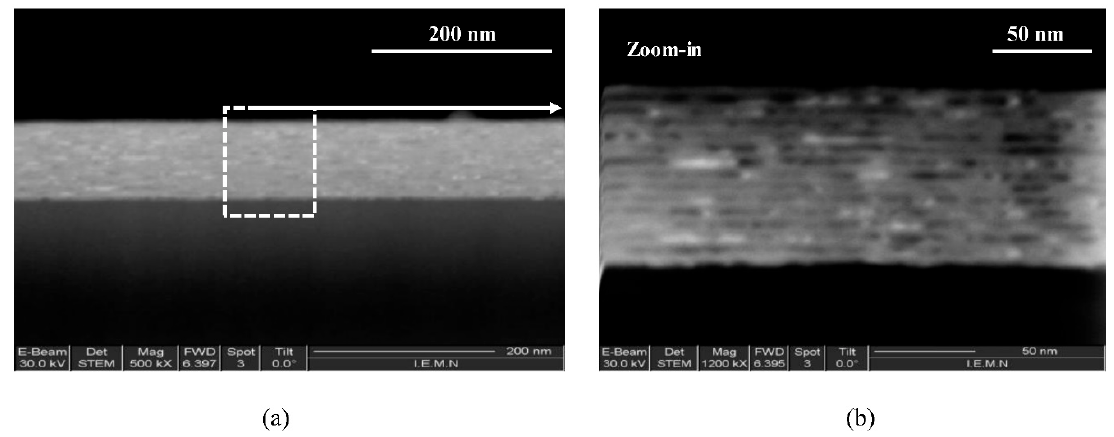
Figure 3. ( a ) TEM, cross-section image of the of a 14 × [TbCo 2 (3.7 nm)/FeCo (4 nm)] nanostructured multi-layer. ( b ) A zoom-in.